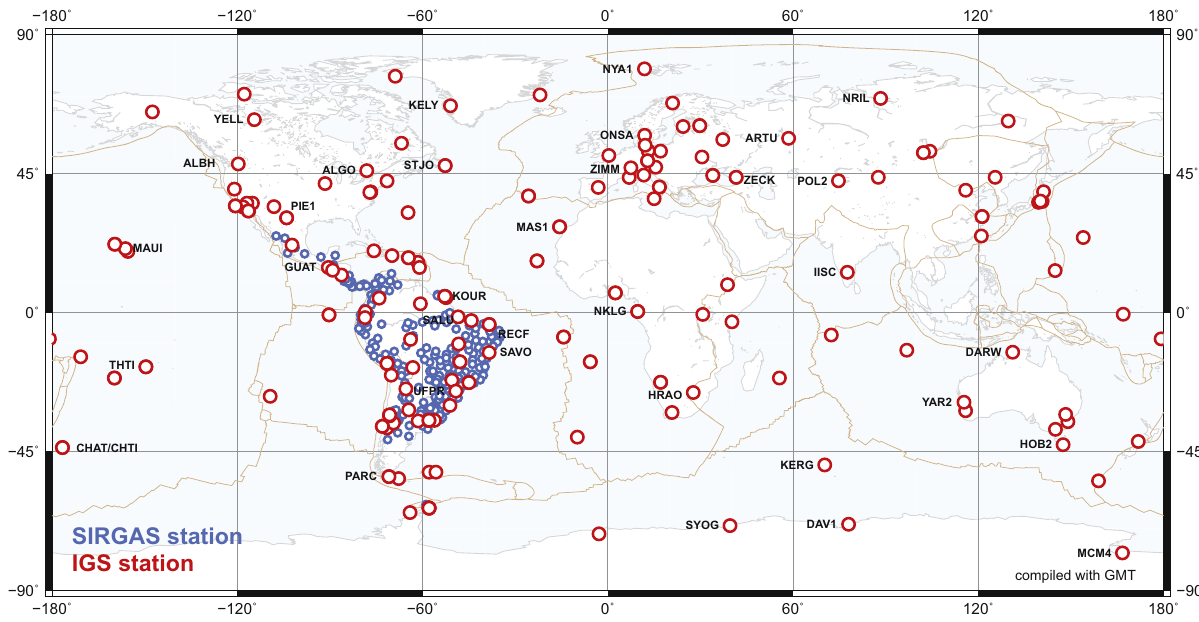
Figure 10: GNSS stations included in SIRGAS - Repro2. Stations with a label represent fi ducial sites in the SIRGAS - Repro2